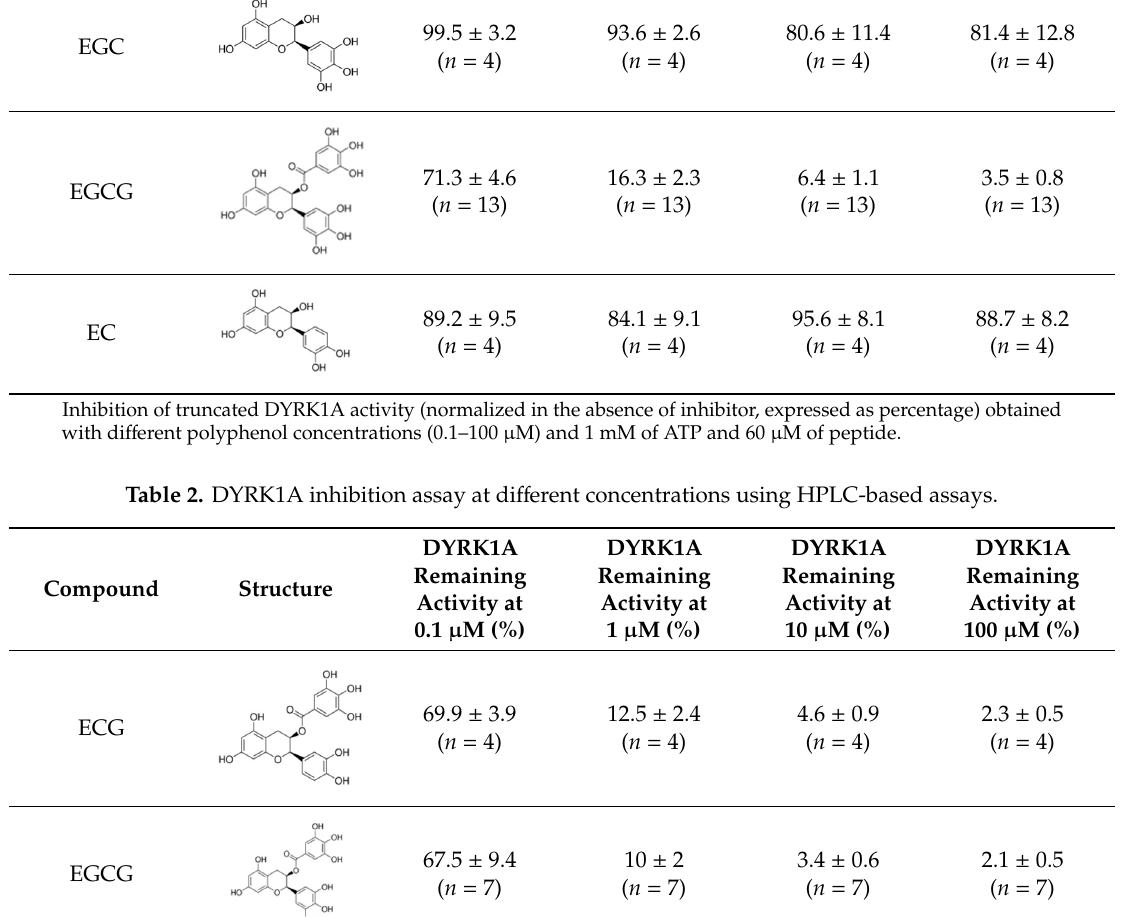
Inhibition of native DYRK1A activity (normalized in the absence of inhibitor, expressed as percentage) obtained with different polyphenol concentrations (0.1–100 µM) and 1 mM of ATP and Table 3. Analysis of the inhibition of DYRK1A- Δ C activity by ECG and EGCG as a function of ATP concentrations.